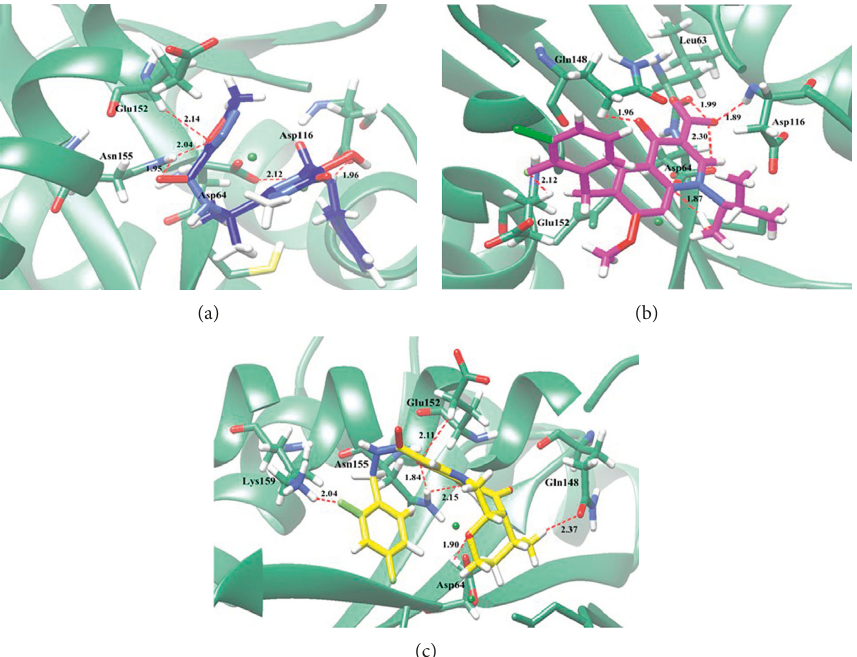
Figure 4: Molecular docking of HIV-1 IN inhibitors with HIV-1 IN. The ribbon model shows the backbone of the HIV-1 IN catalytic domain with all interacting amino acid residues shown as stick models and colored by heteroatoms. H-bond interactions are shown as red dashed lines and represent bond length in angstroms (˚A). Mg 2+ ions are shown as green balls. (a) Raltegravir, (b) elvitegravir, and (c)